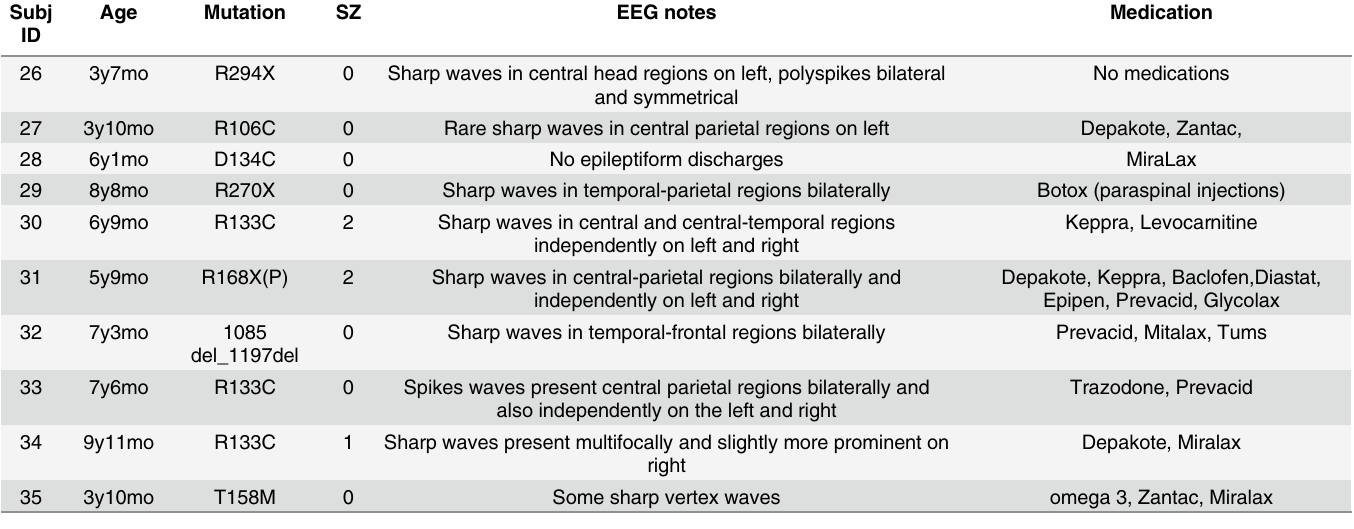
Table 3. Medications and EEG